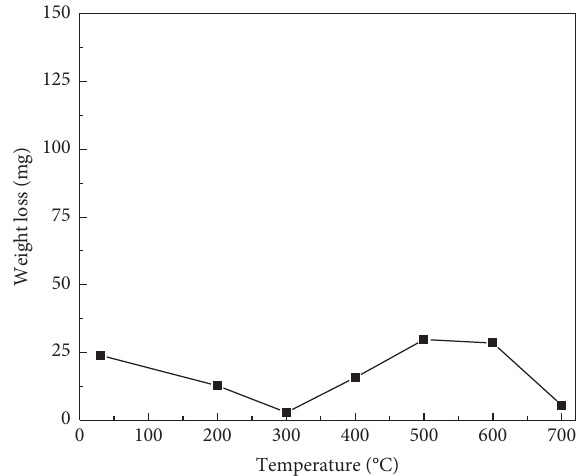
Figure 11: Effect of temperature on the wear weight losses of S0